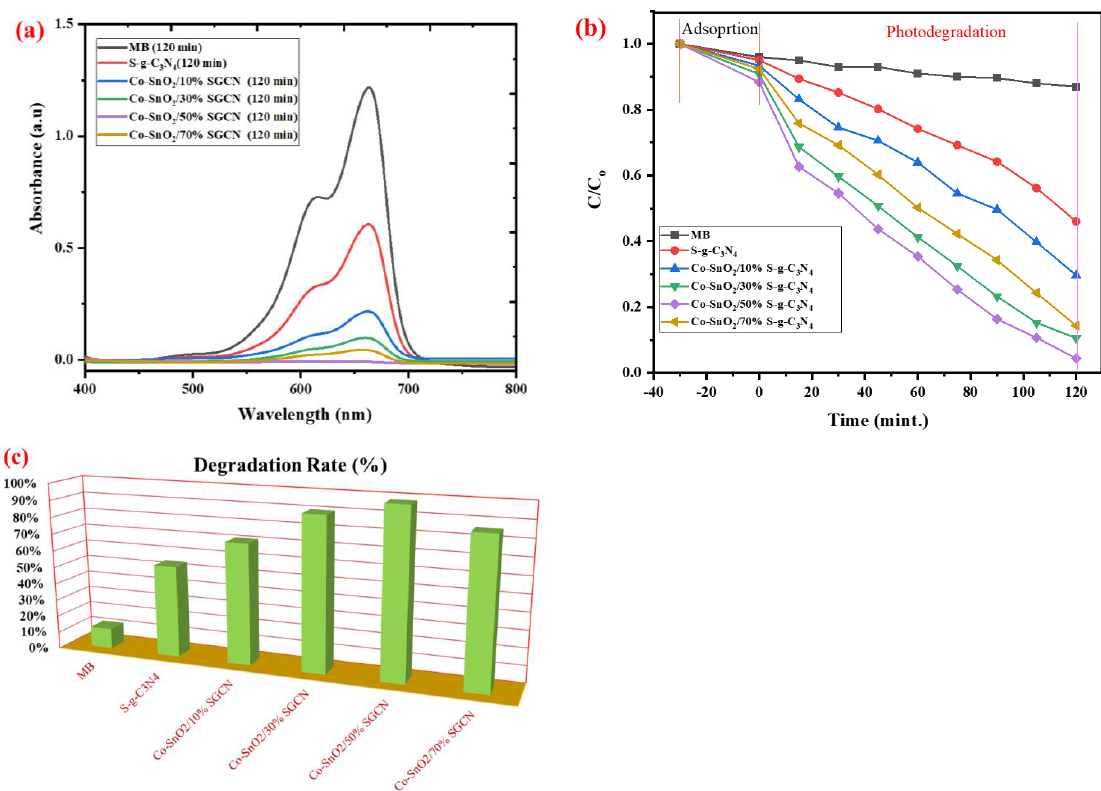
Figure 7. Degradation contours ( a ) Degradation rate ( b ) % Degradation of MB ( c ) by Co-SnO 2 /SGCN.